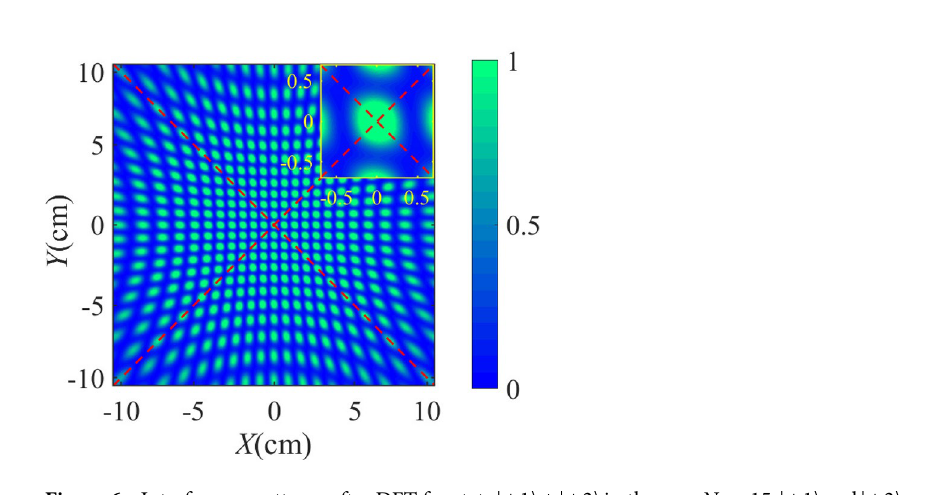
Figure 6. Interference patterns after DFT for state respectively. 0 is obviously invalid. It means order r